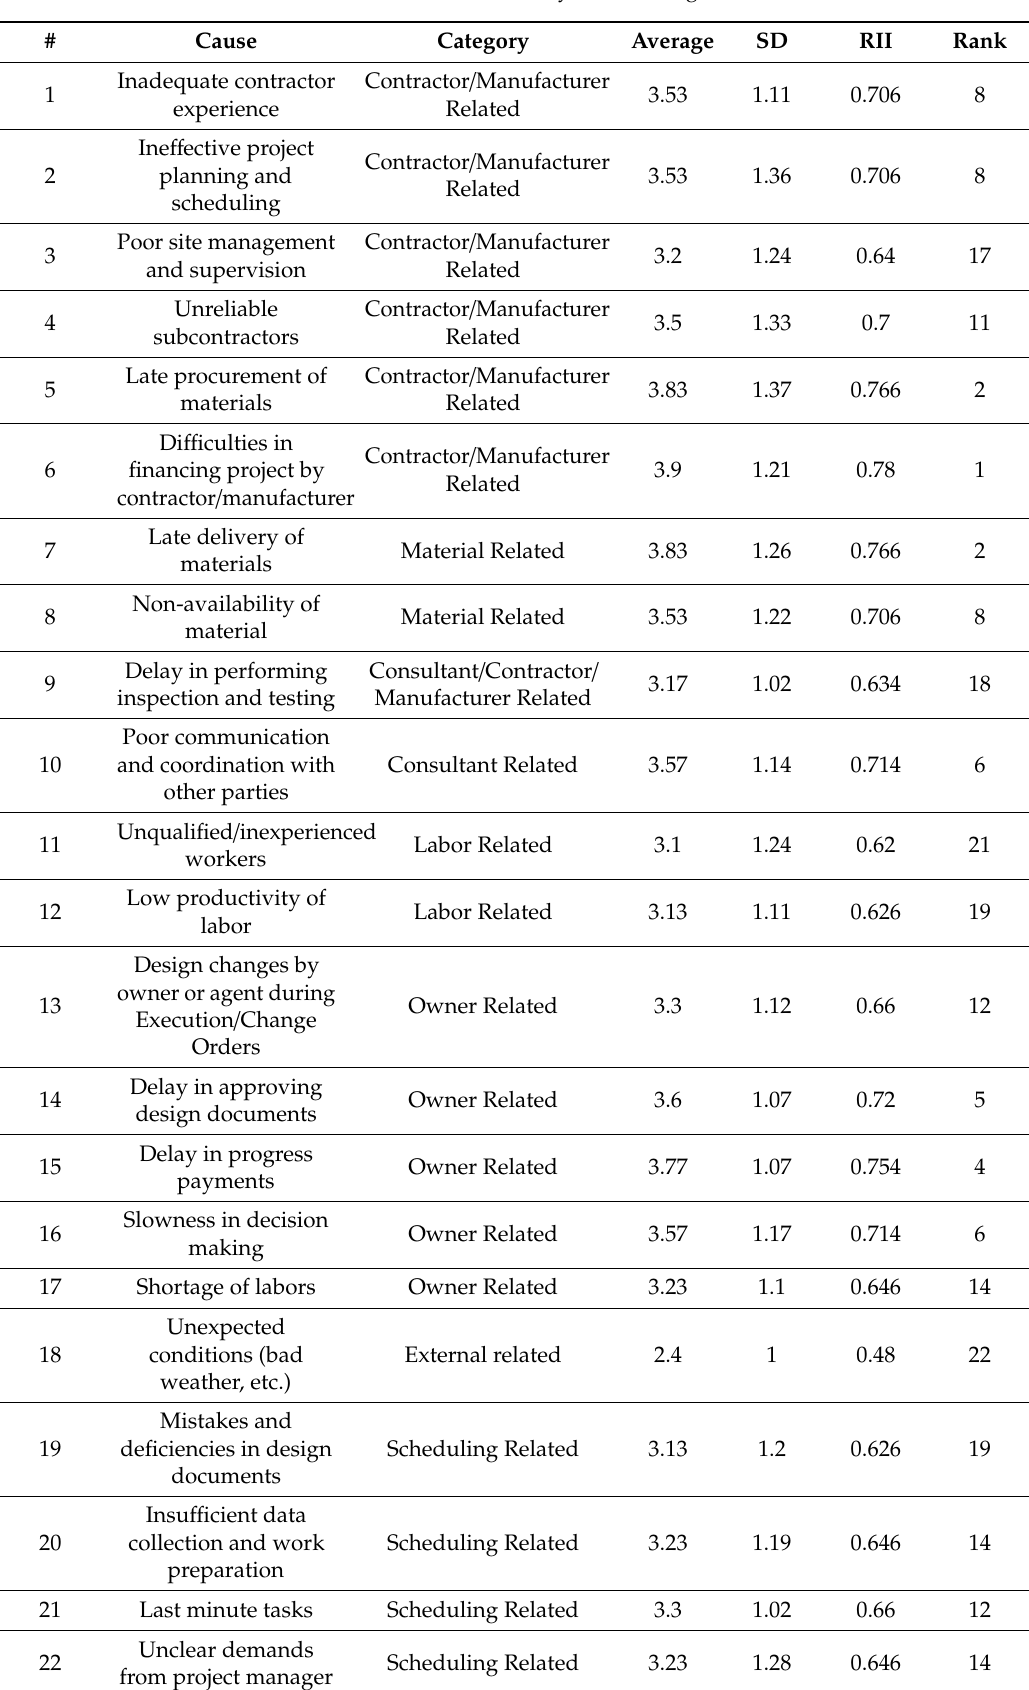
Table 2. The identified causes of delay, their average, SD, and